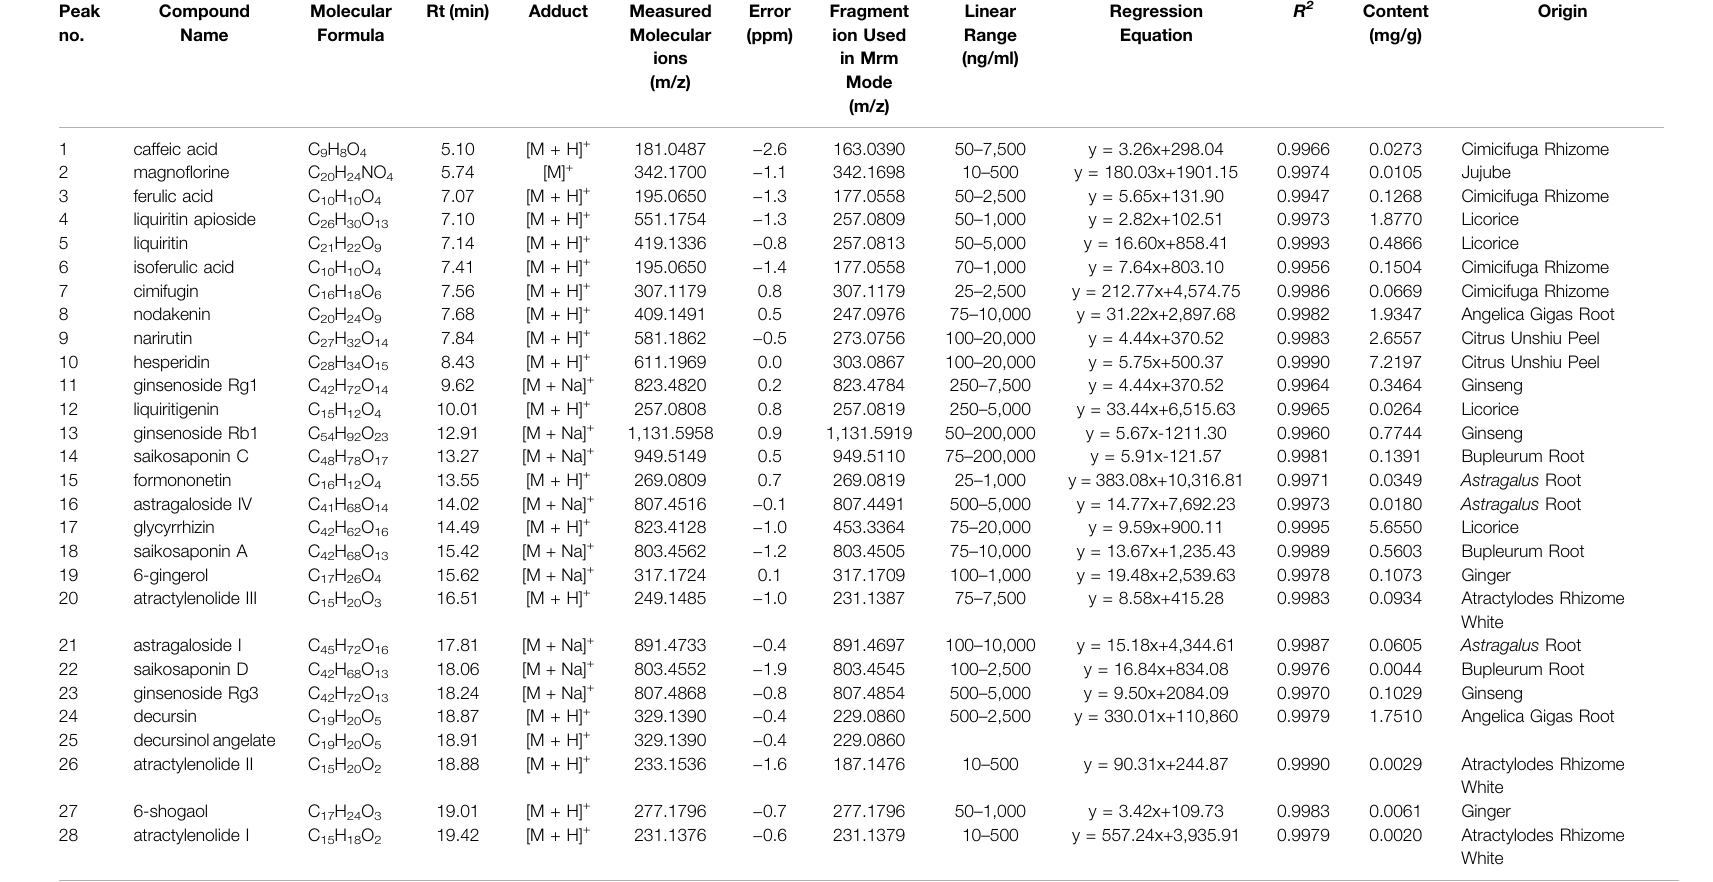
TABLE 2 | Qualitative and quantitative analysis of chemical components authentically in BJIKT. Peak